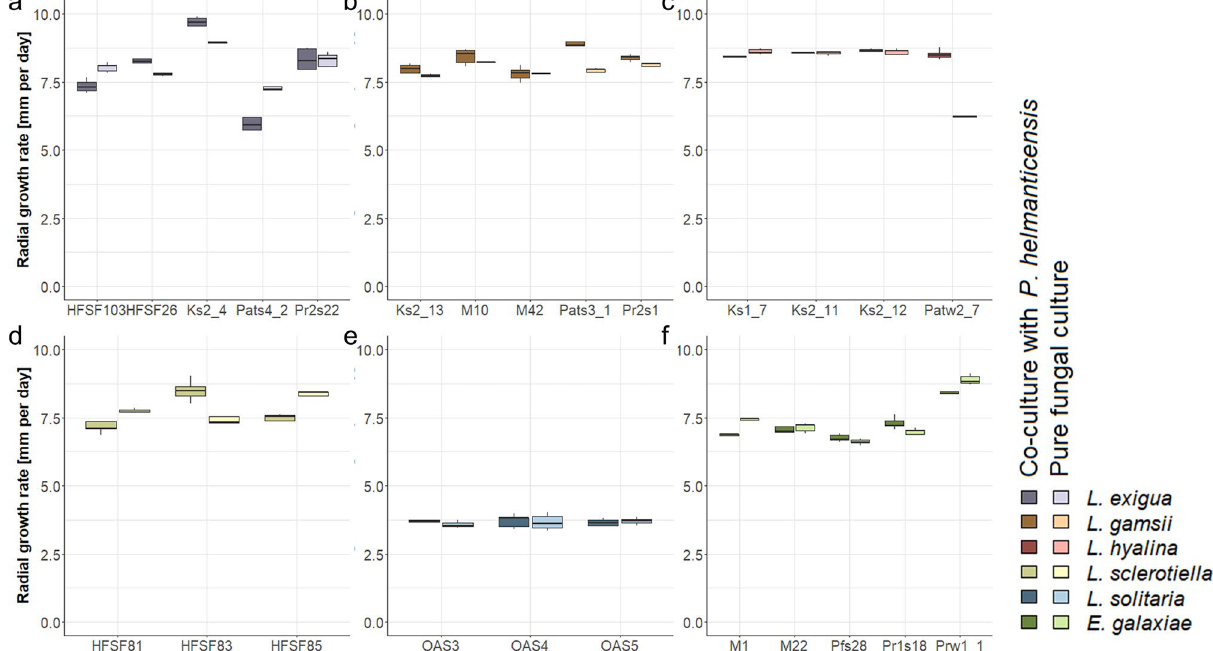
Figure 2. Daily radial growth rate of pure Linnemannia and Entomortierella cultures as well as co-cultures with P. helmanticensis on nutrient rich PDA medium . ( a ) L. exigua, ( b ) L. gamsii, ( c ) L. hyalina, ( d ) L. sclerotiella, ( e ) L. solitaria, ( f ) E.